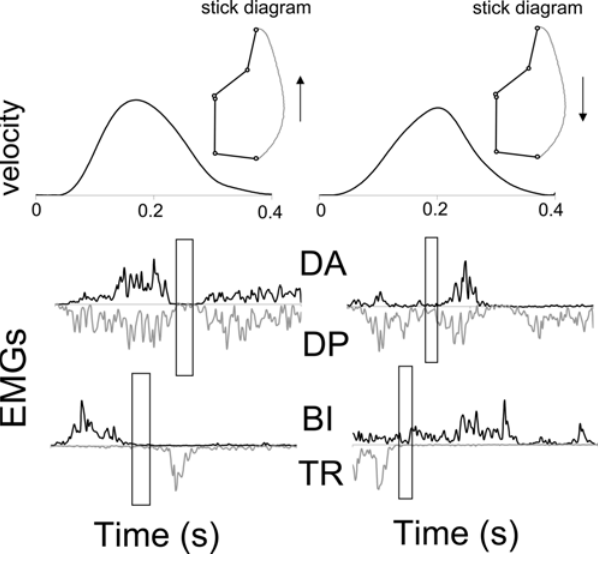
Figure 4. Typical experimental data of a 2-dof arm movement performed in upward (left) and downward (right) directions. Finger velocity profiles (upper part) and four EMGs (lower part) are amplitude normalized. The periods of muscular inactivation are emphasized by means of rectangular frames. The same abbreviations as in Figure 3 are